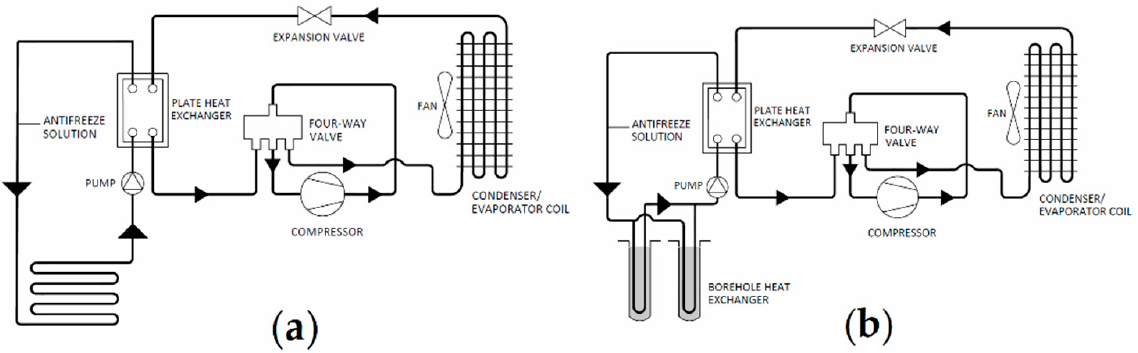
Figure 10. The schematic of the GCHP ( a ) with horizontal heat exchangers and ( b ) with vertical heat exchangers in heating mode.